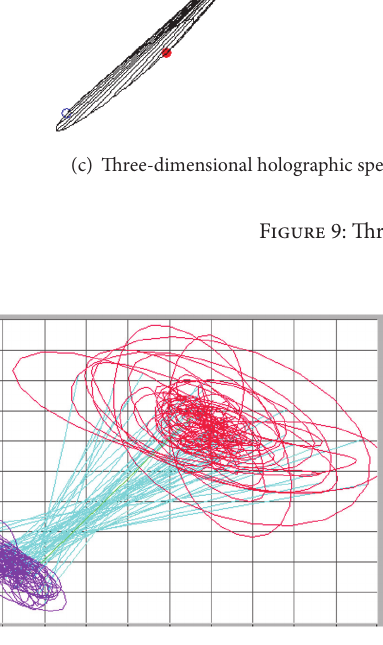
Figure 10: Filtered three-dimensional vibration with two sections projected in a two-dimensional plane.